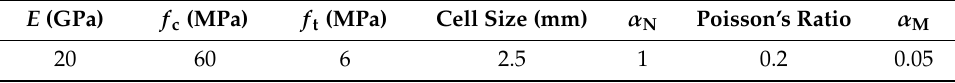
Table 8. Values of input parameters in the numerical analyses about DEN beam shear test.